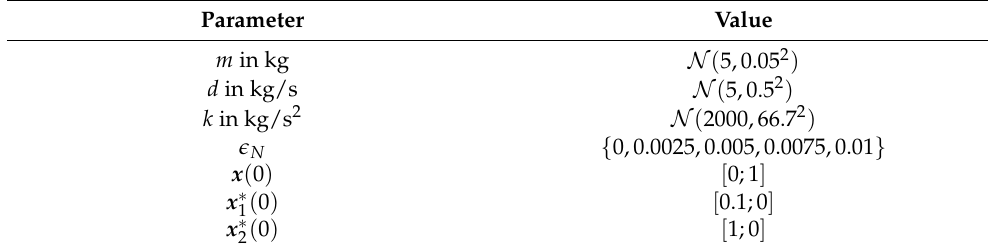
Table 1. Oscillator parameters in numerical uncertainty analysis.